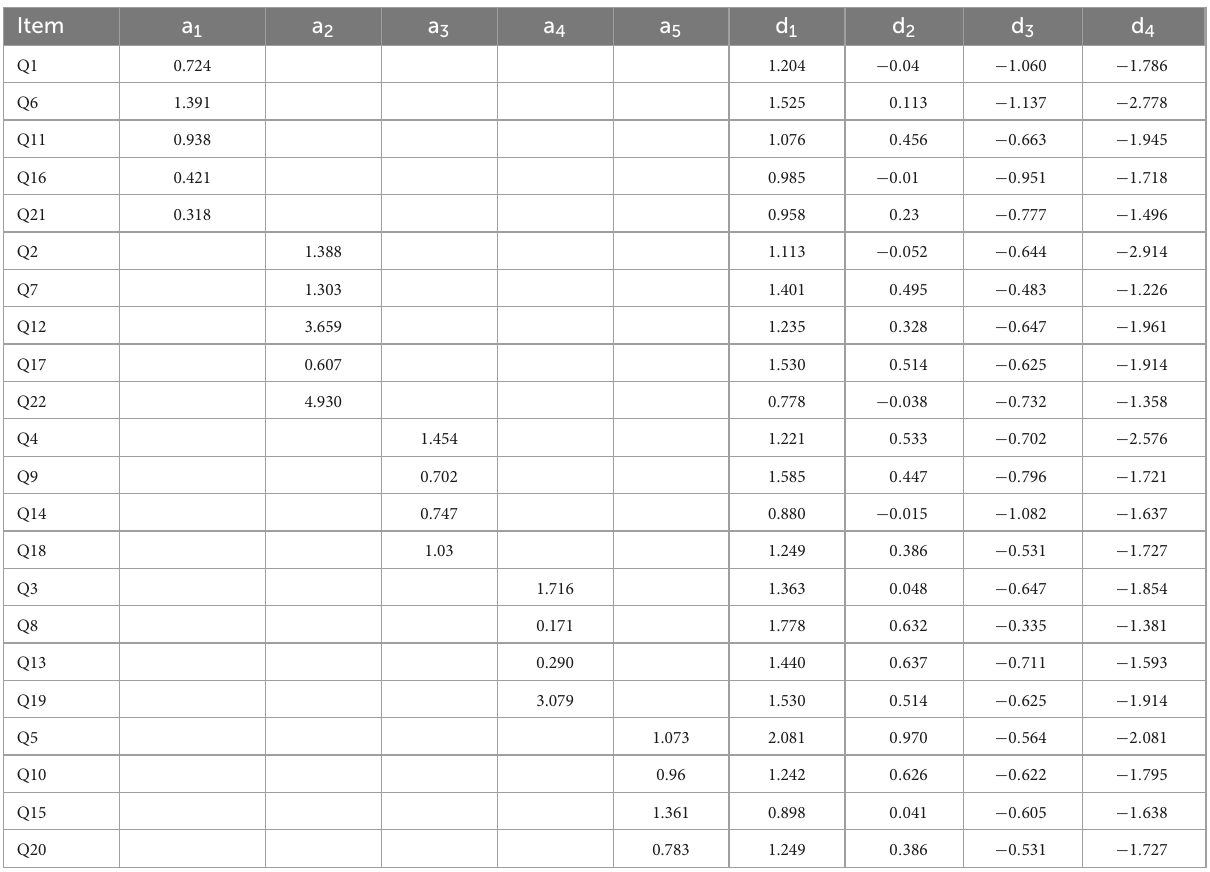
TABLE 2 Discrimination and threshold parameters for the 5-factor confirmatory MIRT